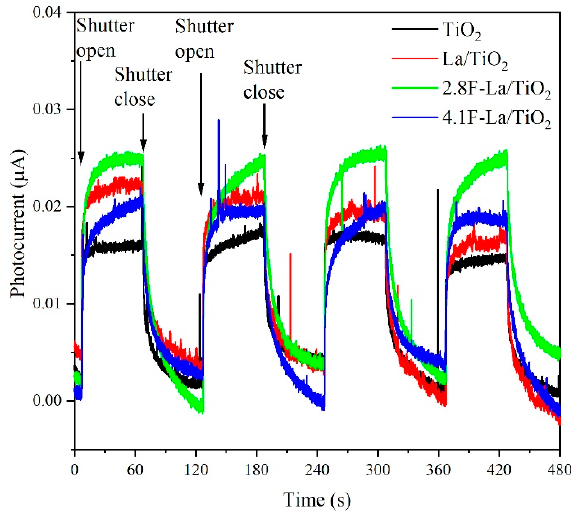
Figure 4. Photocurrent responses of prepared photocatalysts under applied external potential 1 V and irradiated under 365 nm.